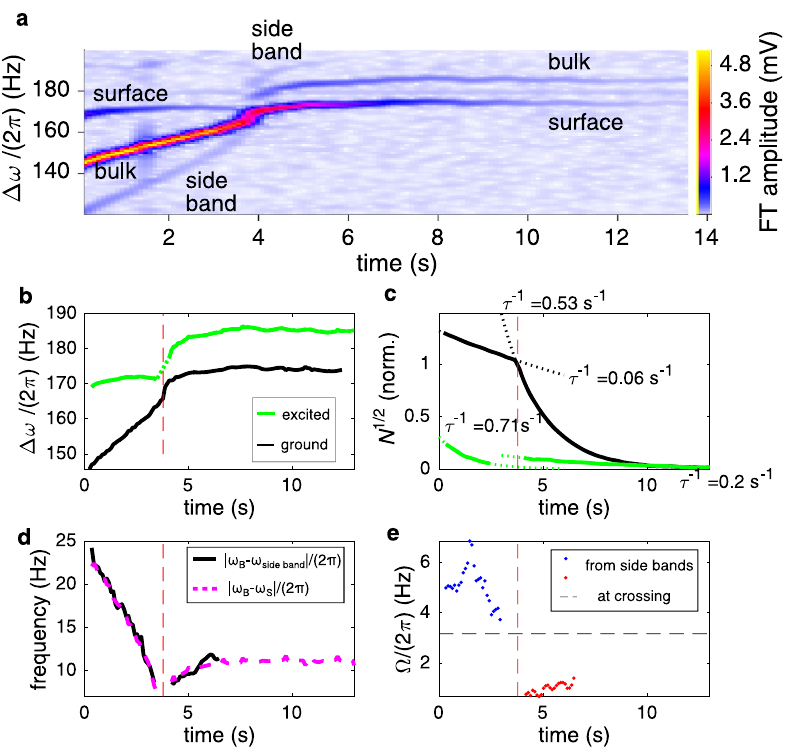
Fig. 5 Two-level time crystal with dynamic coupling at large N B . a The time crystals are created at t = 0. Frequencies are plotted in the rotating frame t ≈ 3.8 s (vertical dash Δ ω = ω − ω 0 . b Initially the ground level (black line) is located in the bulk and the excited level (solid green line) at the surface. At lines), the ground level moves smoothly to the surface in an avoided crossing. Dotted green line shows a linear interpolation of the excited-state frequency at the crossing. c Most of the population follows the ground level (black line) movement from bulk to surface, identi fi ed by a sharp increase in the exponential relaxation rate τ ( fi tted dash lines and values marked in the fi gure). Total population is normalised to one at the crossing. d Population oscillations between the time crystals are seen as a side-band of the bulk crystal trace in panel a at frequency ω side band . The side band ’ s frequency separation from the bulk trace, ∣ ω B − ω side band ∣ (solid black line), is equal to the frequency separation of the main traces, ∣ ω B − ω S ∣ (magenta dash line). e The coupling Ω can be extracted from the side band and main trace amplitudes, in good agreement with that estimated by linear interpolation from the separation of the main traces in panel b (horizontal dash line). In this measurement, temperature was 150 μ K and ω 0 /(2 π ) = 624